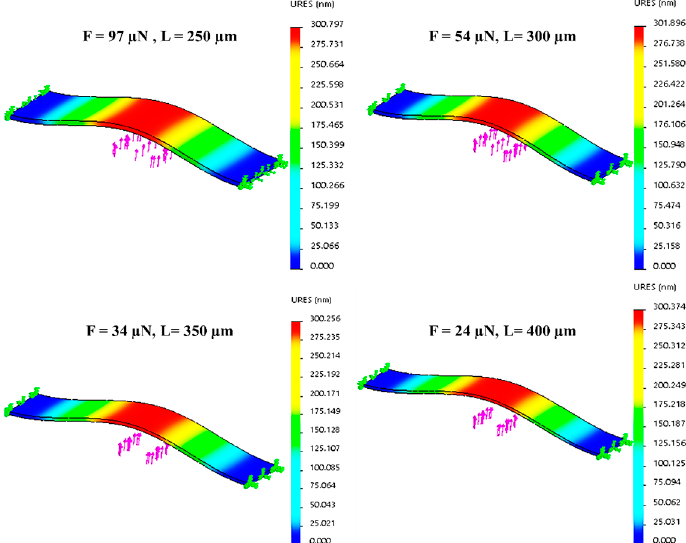
Figure 17. Force tuning and displacement analysis for different beam length under point force.